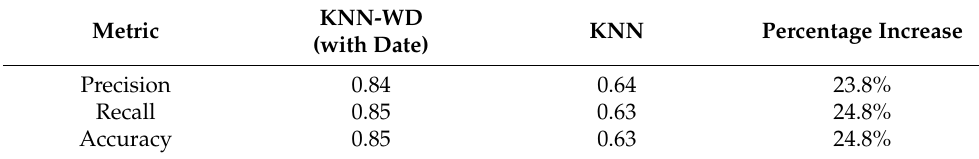
Table 5. Precision, recall, and accuracy of the two algorithms.